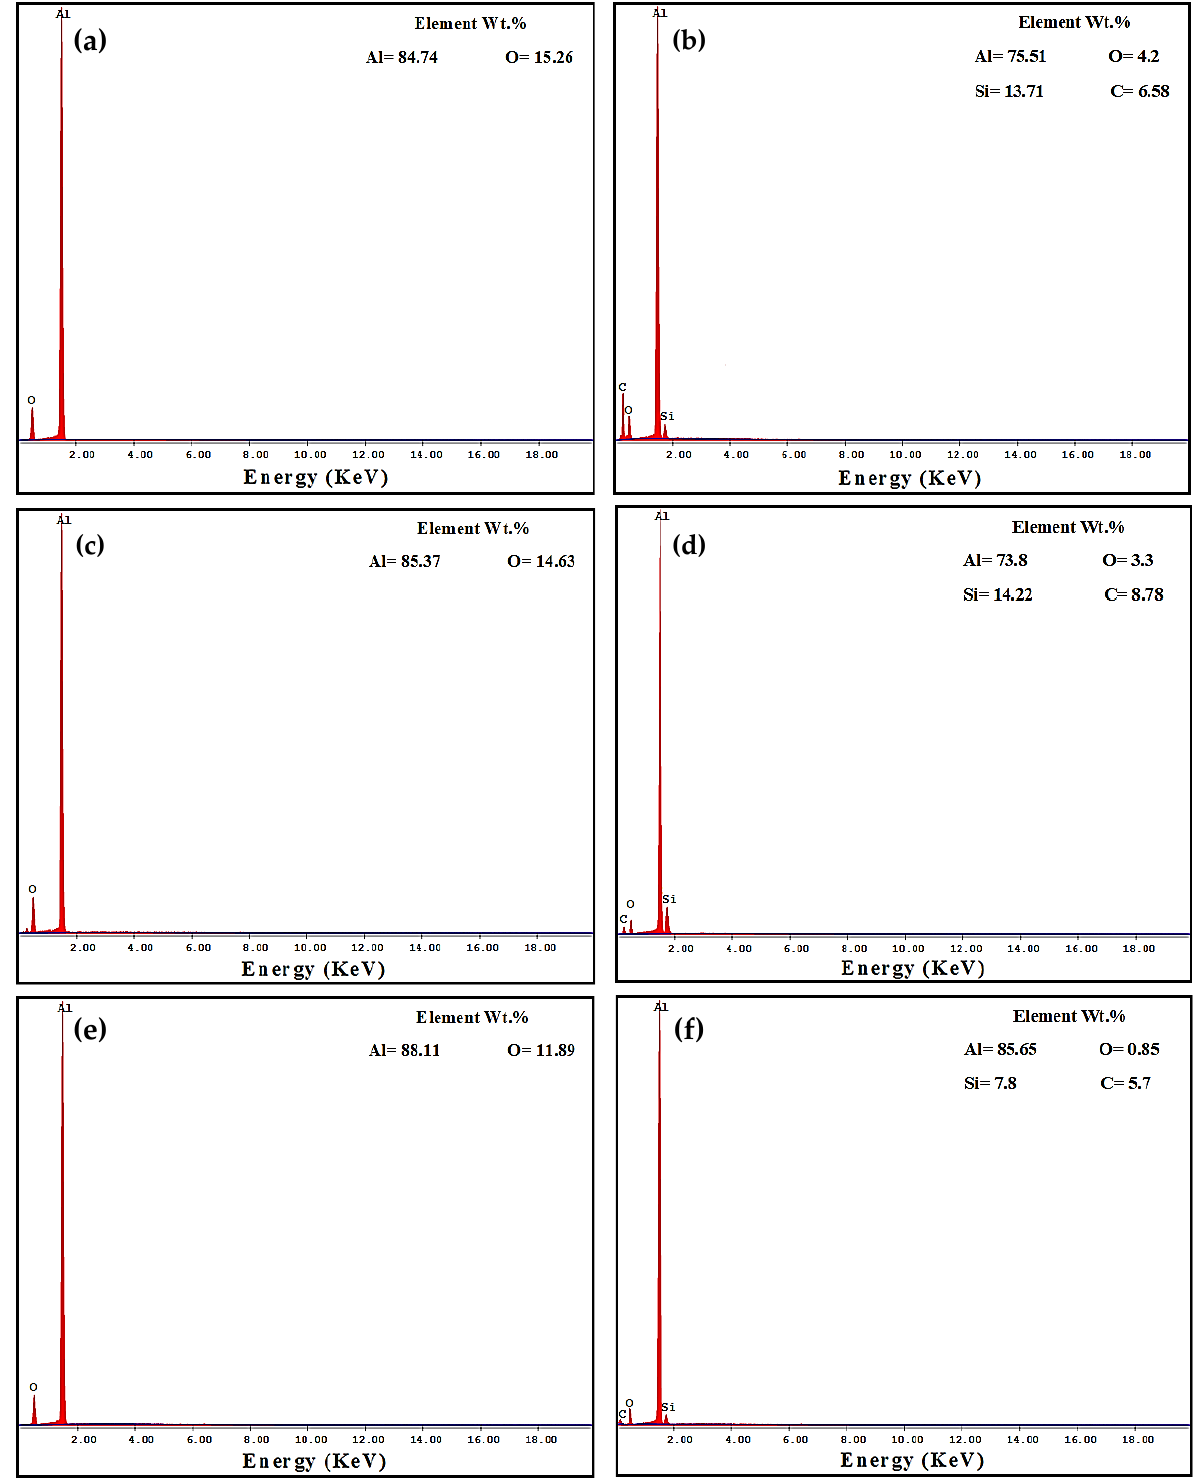
Figure 10. EDS analysis of the worn surface morphology of ( a ) PM Al-20% Al 2 O 3 , ( b ) PM Al-20% SiC, ( c ) HPT-processed Al-10% Al 2 O 3 , ( d ) HPT-processed Al-10% SiC, ( e ) HPT-processed Al-20% Al 2 O 3 , and ( f ) HPT-processed Al-20% SiC samples obtained under an applied load of 2.5 N and a sliding distance of 315 m.